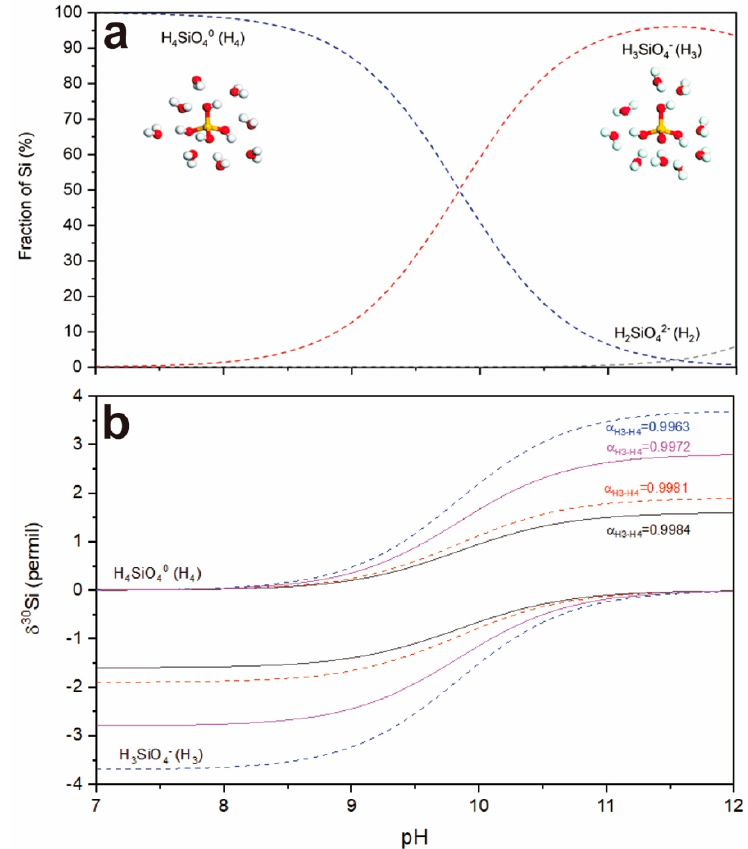
Figure 3. ( a ) Distribution of H4, H3, and H2 species in aqueous solution as a function of pH according to the dissociation constants of pK a1 = 9.84 and pK a2 = 13.2 at 298 K and 0 M ionic strength condition Fujii et al. [86]. Inserted are structures of hydrated silicic acid H 4 SiO 40 (H4) and its hydrated dominant-associated base H 3 SiO 4 − (H3) in aqueous solution. Silicon, oxygen, and hydrogen atoms are represented by yellow, red, and white color. ( b ) δ 30 Si of H4 and H3 species relative to the bulk solution ( δ 30 Si = 0) with α H3-H4 values of 0.9963, 0.9972, 0.9981, and 0.9984 in the solution pH range of 7–12. The α H3-H4 values used were referred to the previous study by Fujii et al. [86].